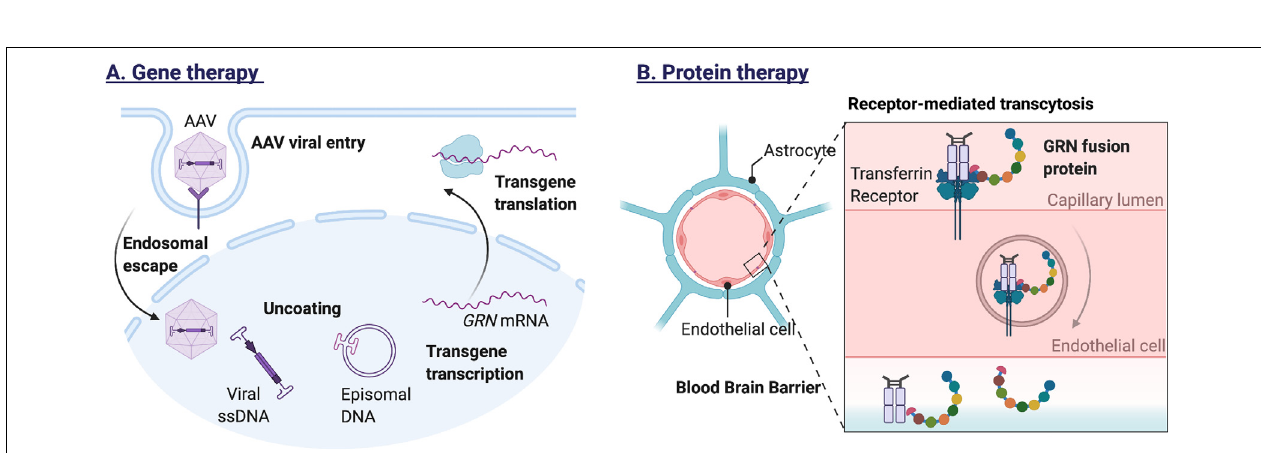
FIGURE 4 | Methods for exogenous GRN expression. (A) Adeno-associated viral vectors, modified to carry the GRN gene, can infect a wide range of cells in the central nervous system. Recognition by cell surface receptors of the host cell triggers endocytosis and endosomal escape of the AAV particle. After nuclear import, the viral DNA is released, allowing transgene expression. Because the viral DNA persists as a nonintegrating stable episome, transgene expression can be prolonged, especially in non-dividing cells (e.g., neurons). (B) To allow intravenous protein therapy, a recombinant human GRN protein has been developed with improved blood–brain-barrier (BBB) penetrance. The GRN fusion protein binds the human transferrin receptor, facilitating receptor-mediated transcytosis across the blood-brain